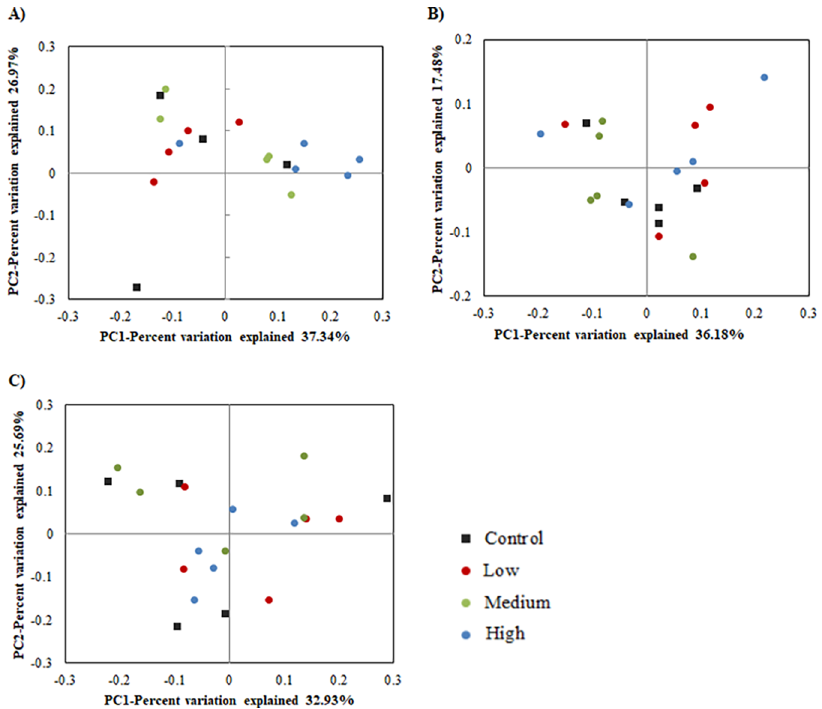
Fig 1. Principal coordinate analysis (PCoA) of taxonomic classification up to genus level using Bray-Curtis distance. A) 4 weeks period, B) 8 weeks period and C) 12 weeks period goats fed with different level of lovastatin.